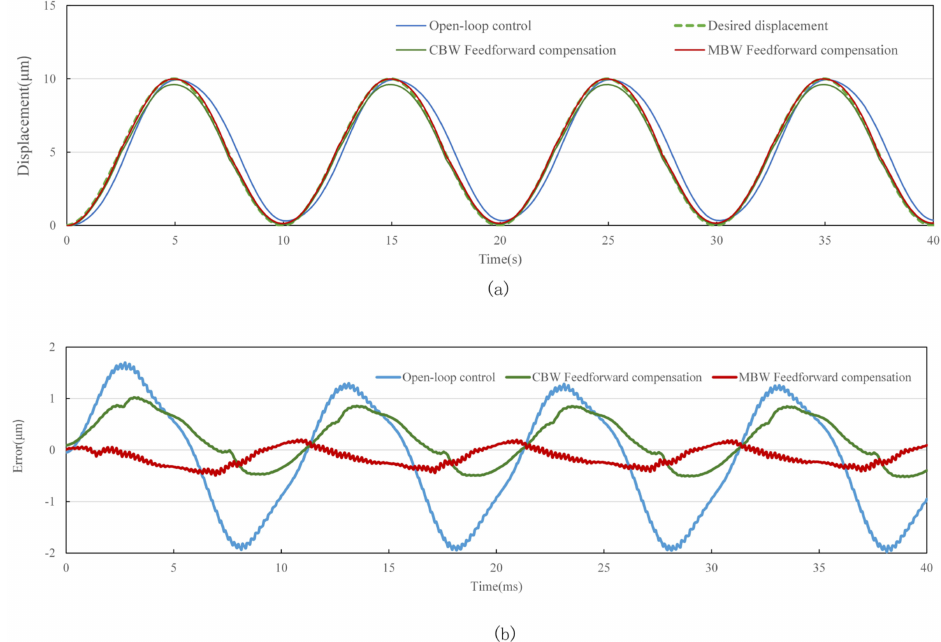
Figure 17. Standard sinusoid signal tracking performance with different control method at 100 Hz. ( a ) tracking displacement. ( b ) error curve.